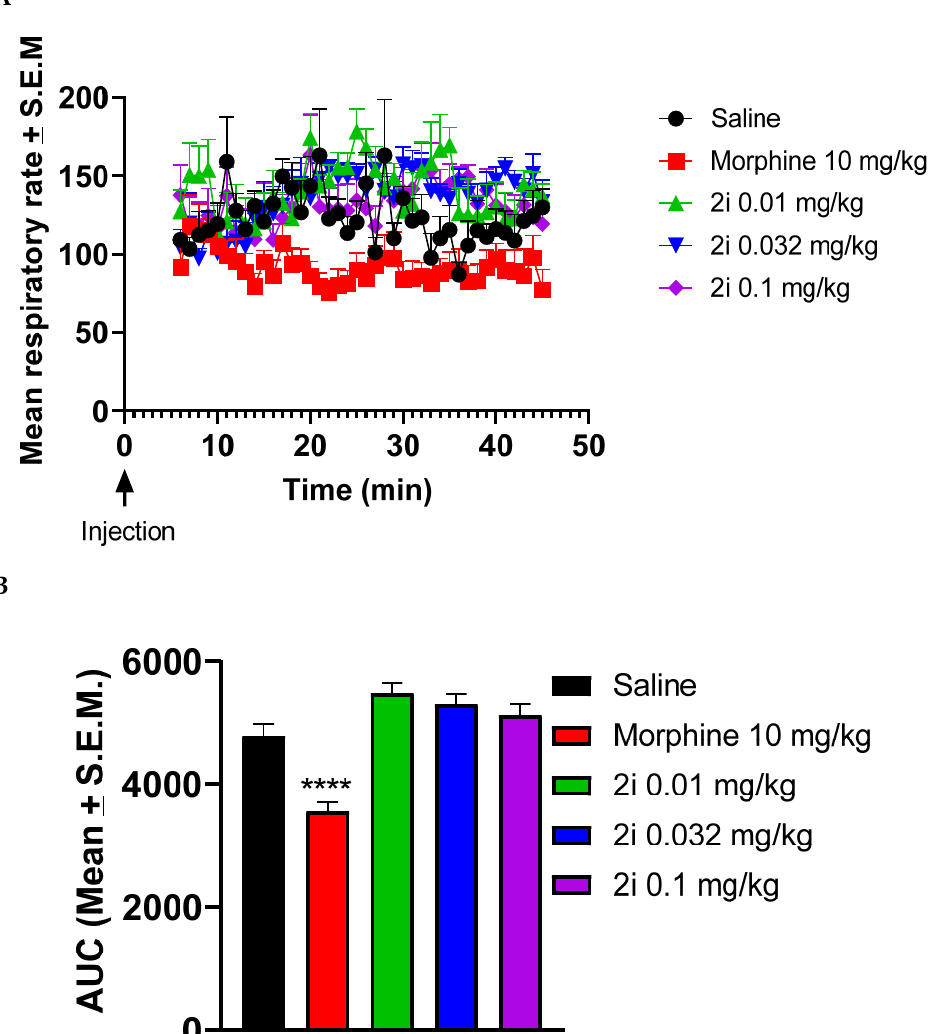
Figure 3. Effects of morphine and 2i on respiratory rate in mice. After acclimation in observation boxes, mice were injected with either saline, morphine 10 mg/kg, or 2i and connected to a throat sensor. Five min later, the recording was started and respiratory rate was measured from 6 min to 45 min post-injection ( A ). Area under the curve (AUC) was calculated from 6 min to 45 min. Morphine significantly reduced respiratory rate compared to saline ( B ). Data are expressed as mean ± standard error of the mean (SEM.) ( n = 6–8) (**** p < 0.0001). One-way ANOVA followed by Dunnett’s multiple comparison test.